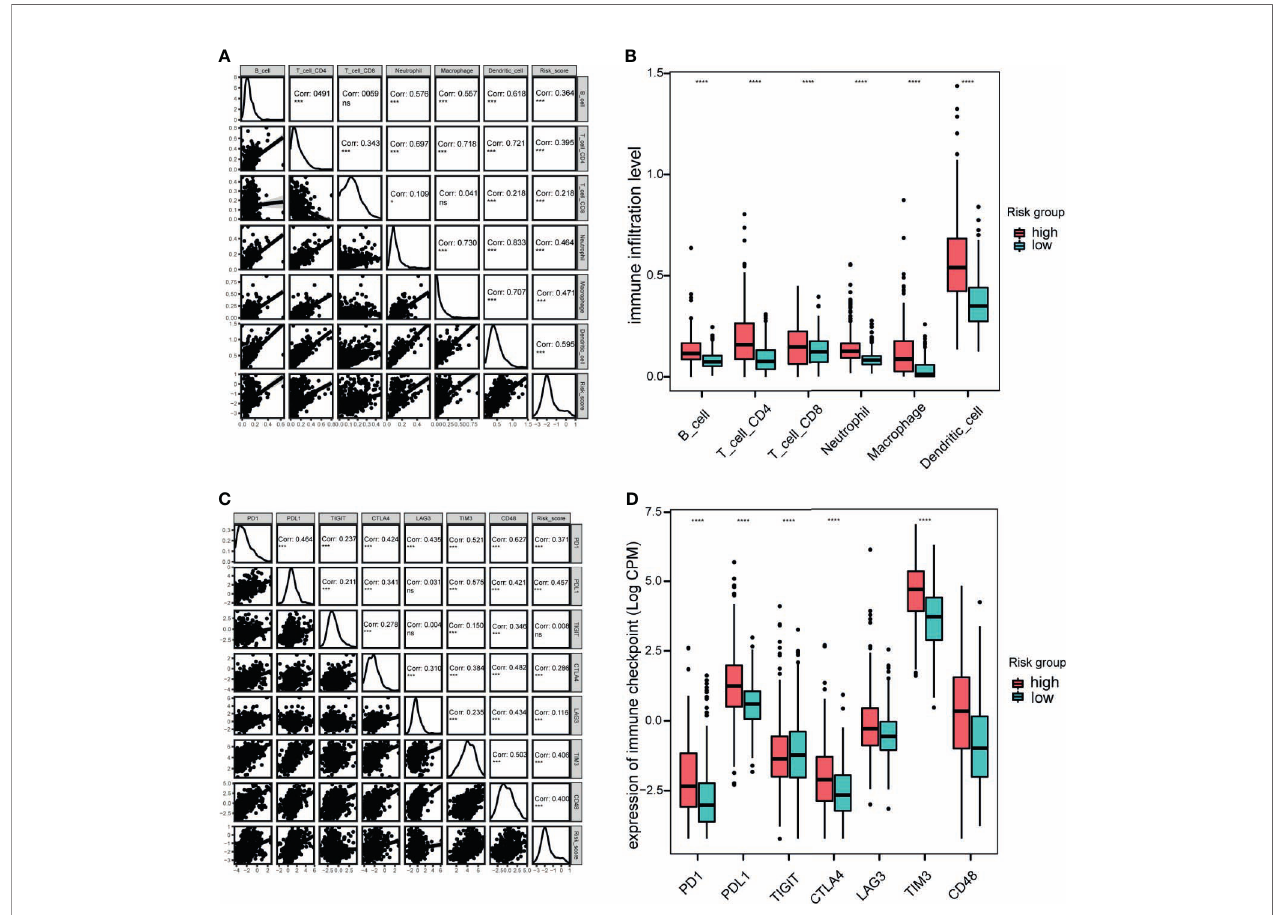
FIGURE 8 | Immune cell in fi ltration and immune checkpoint analysis in the TCGA cohort. (A) , Correlation between immune cell in fi ltration and risk scores. (B) , Boxplot indicating the levels of immune cell in fi ltration in high-risk and low-risk LGG patients. (C) , Correlation matrix of seven immune checkpoint proteins and associated risk scores. (D) , Expression levels of immune checkpoint proteins in high-risk and low-risk LGG patients. * P < 0.05, *** P < 0.001, **** P < 0.0001, ns, not signi fi